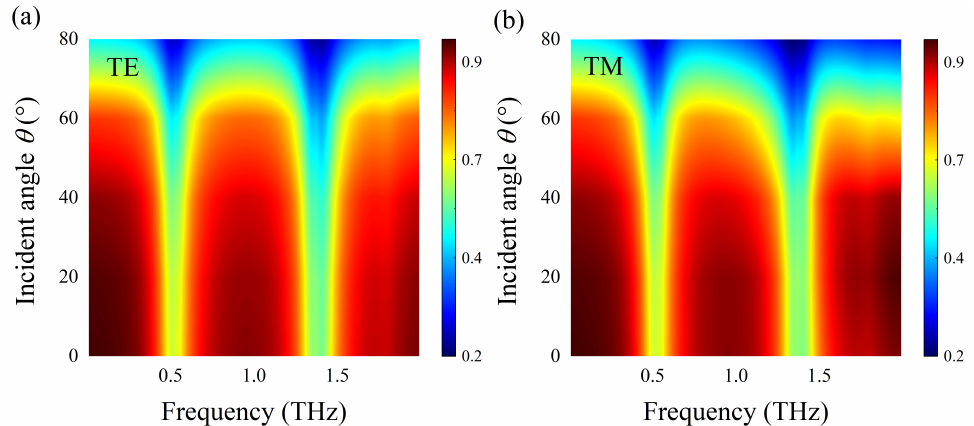
Figure 14. ( a , b ) Transmission spectra of lactose-covered DAIGS at different incidencce angle θ under TE or TM incidence waves.